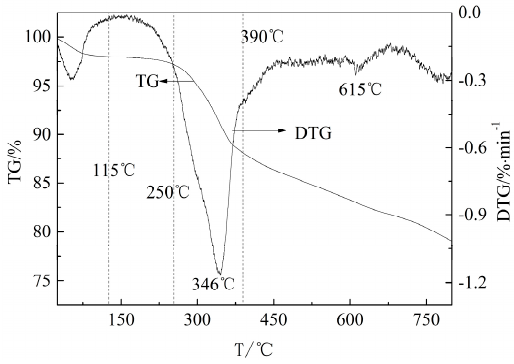
Figure 7. TG and TDG curves for reducing ocean manganese nodules using sawdust.